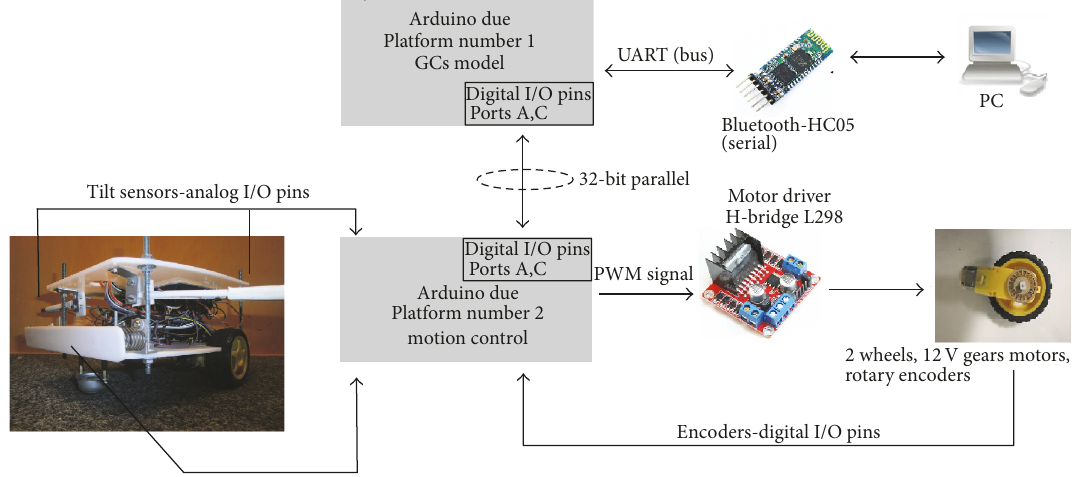
Figure 4: Hardware block diagram of